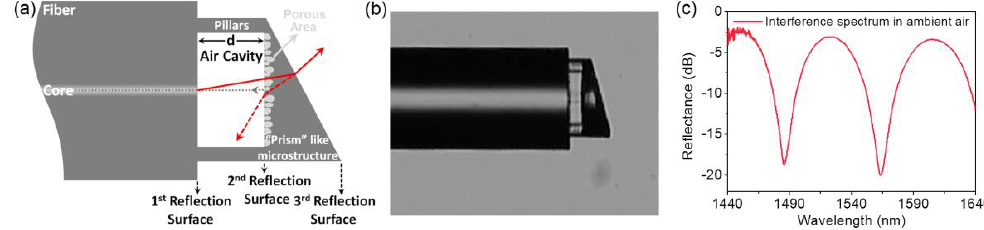
Figure 1. ( a ) Design of the FP microprism resonator onto the endface of the SMF-28e fiber. Grey dashed line corresponds to the reflected light that is recording, while red solid line and red dashed line correspond to the guided light for the maximum angle of the Numerical Aperture (NA) of the core and the reflected light from the outer surface of the microstructure respectively. The porous area on the second reflection surface is also presented with light grey “dots”; ( b ) Optical microscope image of the fabricated microprism resonator; ( c ) Interference spectrum on the resonant probe in ambient air conditions.